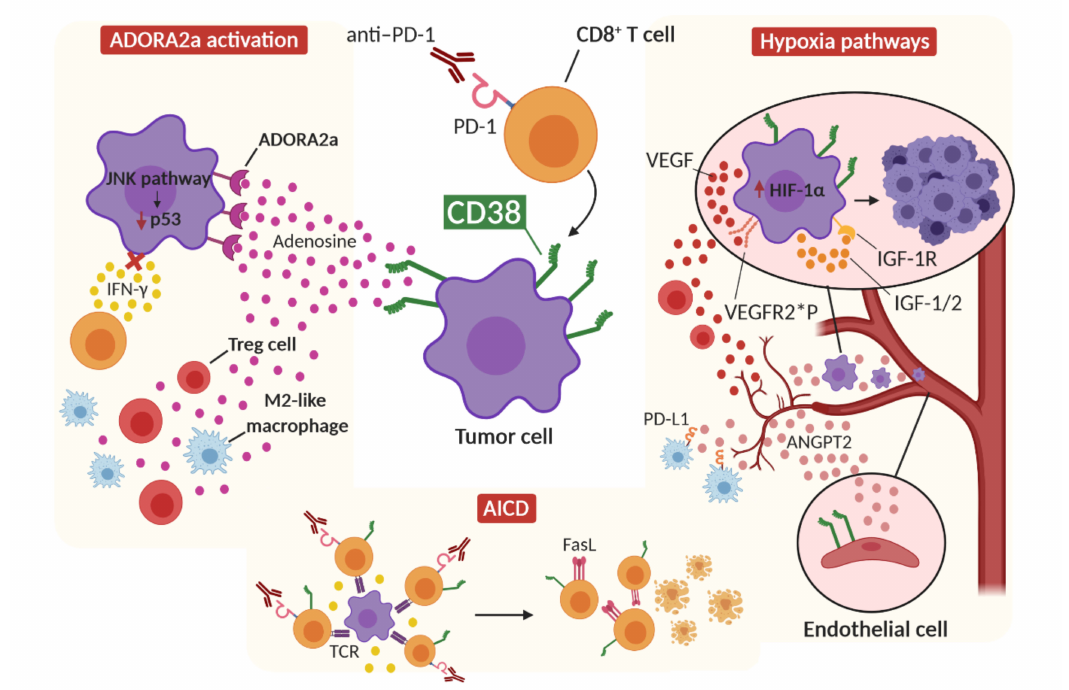
Figure 3. Proposed CD38-dependent mechanisms of hyperprogression. The upregulation and activation of CD38 after IC blockade therapy, together with the action of enzymes that catabolize ATP and ADP (not shown), lead to the release of adenosine into the tumor microenvironment. The activation of ADORA2a receptors on tumor cells by adenosine leads to the blockade of the IFN- γ pathway, making the tumor cell resistant to cytotoxic IFN- γ action, as well as the activation of oncogenic pathways, such as the JNK signaling pathway, which leads to the downregulation of p53. The action of adenosine also increases Treg cells and the polarization of M2 macrophages in the tumor microenvironment. CD38 also promotes the activation of AICD after the hyperactivation of tumor-specific CD8 + T cells by ICI therapy, and induces the expression of FasL on T cells. CD38 also induces the release of Angiopoietin-2 from endothelial cells, leading to increased angiogenesis, PD-L1 expression on M2-like macrophages and enhanced tumor invasion. Finally, CD38 induces the expression of HIF-1 α in tumor cells, which can, in turn, induce the production of VEGF and IGF factors. VEGF can establish paracrine signaling, promoting the recruitment of Treg cells, and autocrine signaling on tumor cells by binding VEGFR2, promoting tumorigenesis and invasion. The polymorphisms rs1870377 A/T and A/A may make this binding stronger. HIF-1 α can also induce the expression of IGF-pathway components, leading to autocrine signaling that results in tumor growth and survival. ANGPT2: Angiopoietin 2; IGF: insulin-like growth factor; IGF-1R: IGF-1 receptor; VEGFR2*P: VEGFR2 receptor with rs1870377 A/T or A/A